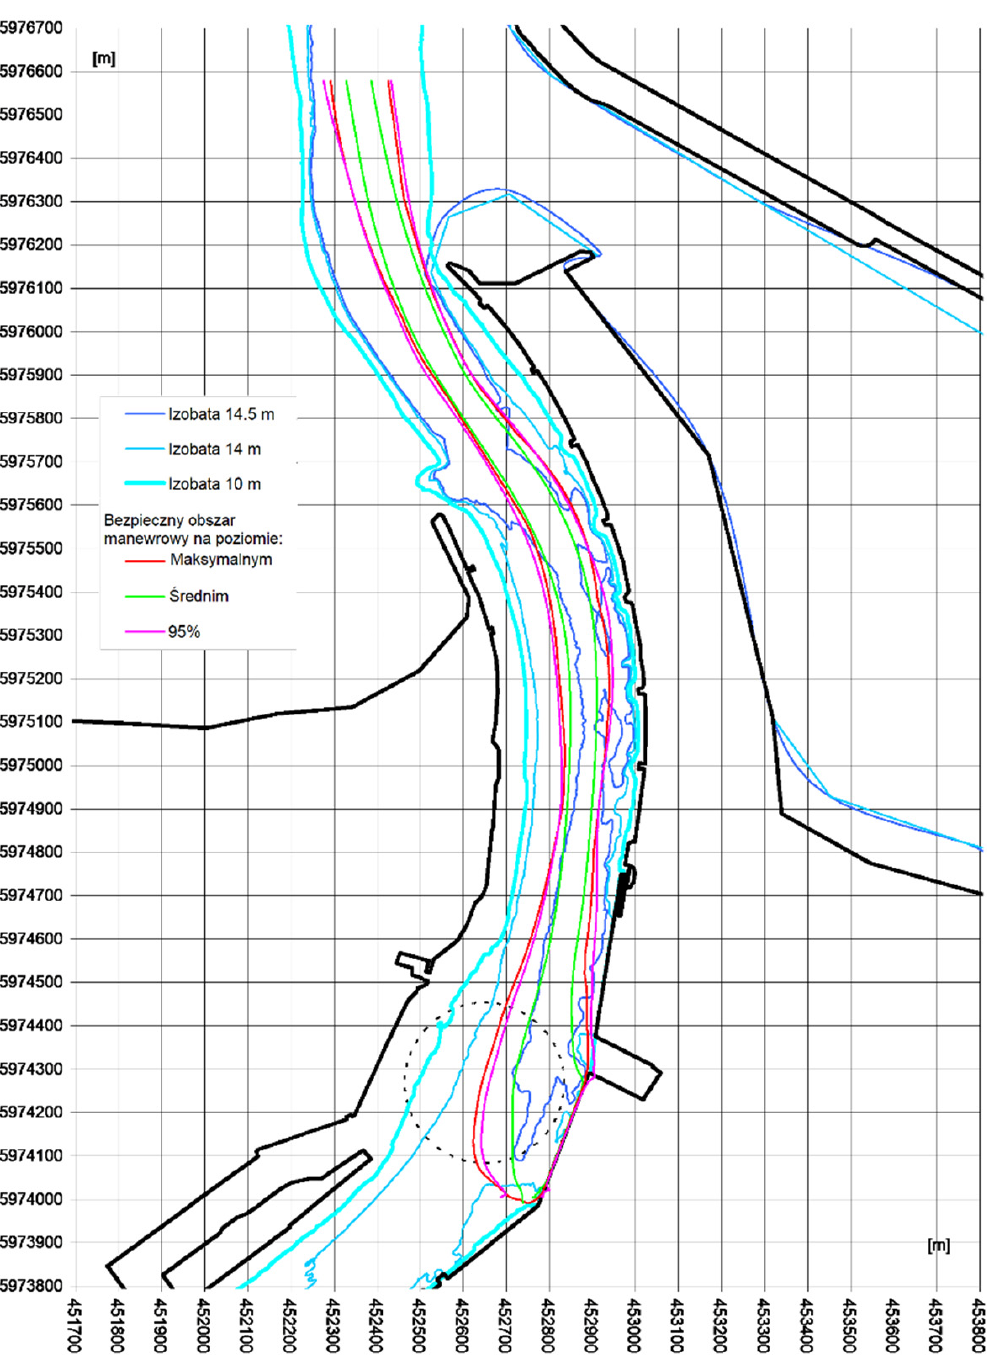
Figure 3. Safe maneuvering areas of the loaded carrier Lc = 300 m, T = 13.5 m at the entrance to Port Ś winouj ś cie. Wind N 10 m/s, ingoing current 0.8 knots, UTM coordinates (zone 33U).